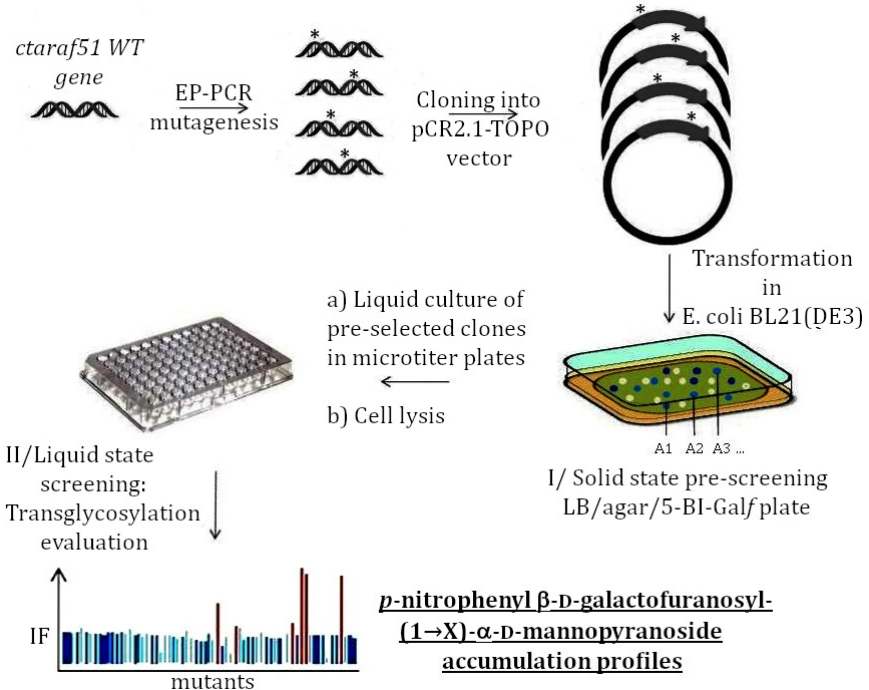
Figure 3. Mutagenesis strategy of the arabinofuranosidase Ct Araf51. IF: improvement factor, calcu- lated according to equation 1. The * outline the random mutations in the gene sequence.